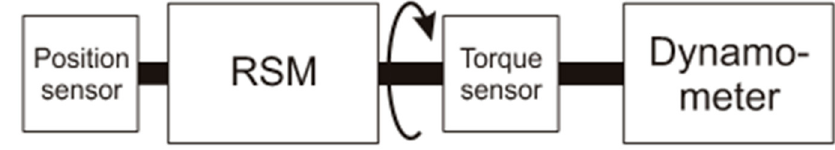
Figure 2. Block model of coupling for purposes of torque measurement.